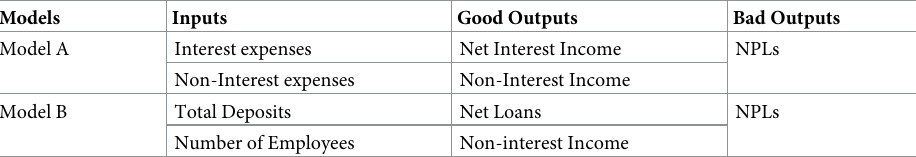
Table 2. Model A & B with different set of inputs and outputs.